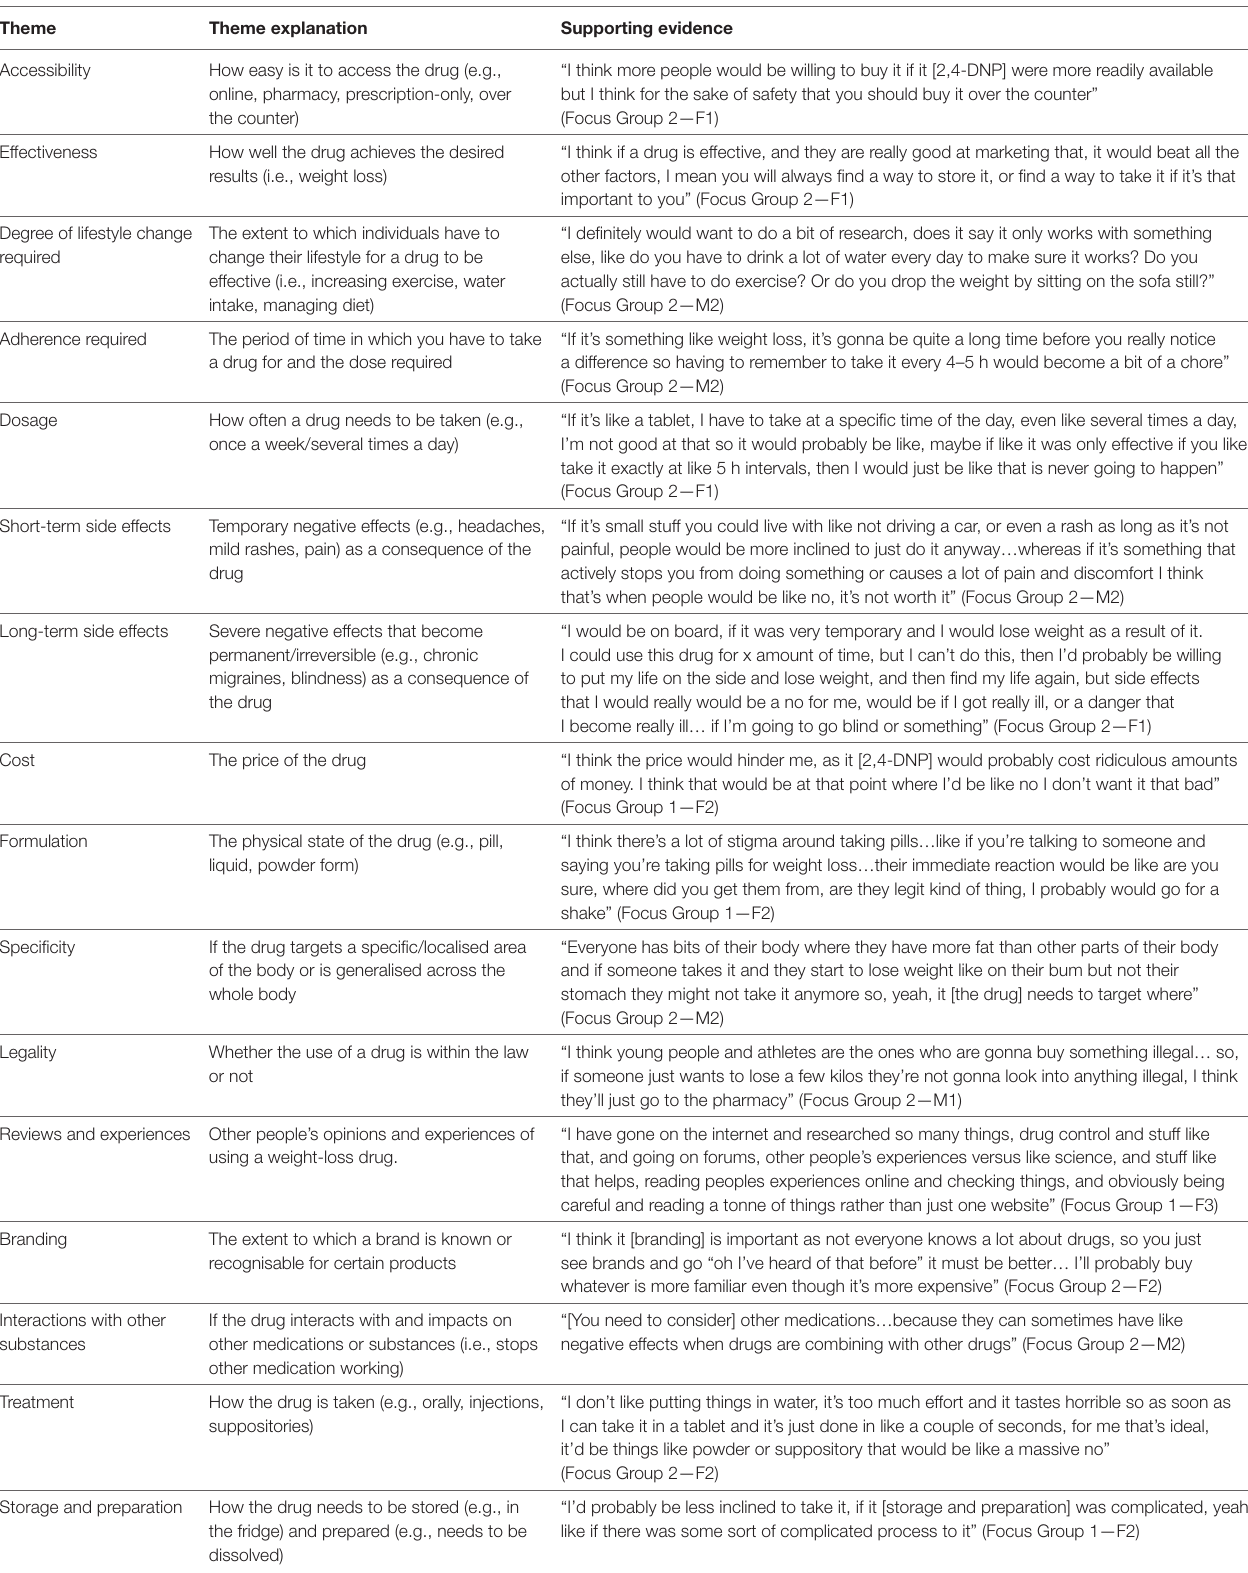
TaBle 2 | Themes, theme explanations, and supporting evidence for the factors considered when buying weight-loss drugs such as